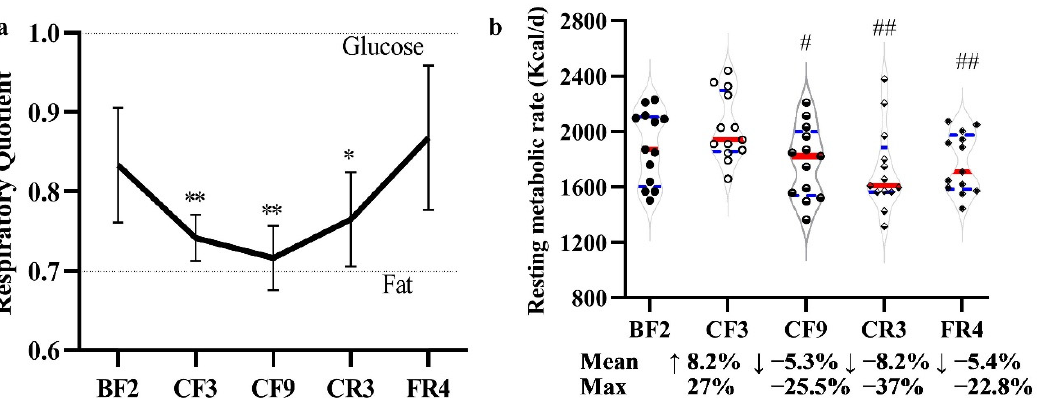
Figure 9. The effect of 10-day CF on the respiratory quotient ( a ) and resting metabolic rate ( b ). * p < 0.05, ** p < 0.01 vs. BF; # p < 0.05, ## p < 0.01 vs. BF; n = 13.BF: before fasting, CF: complete fasting, CR: calorie restriction, FR: full recovery; the number depicts days.